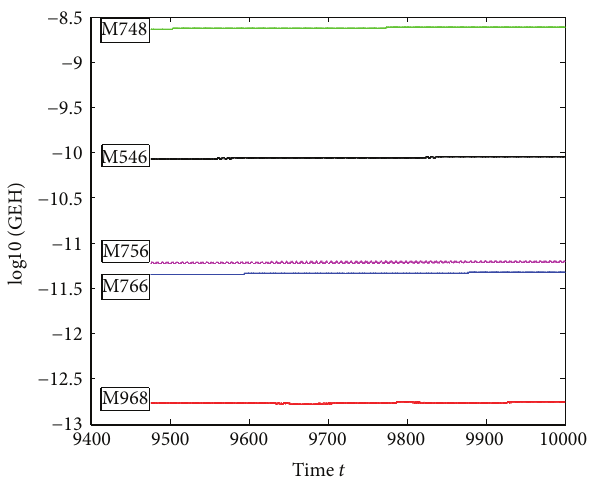
Figure 5: Errors of the Hamiltonian function of (28) on [0, 10000] , with ℎ = 𝜋/60 .